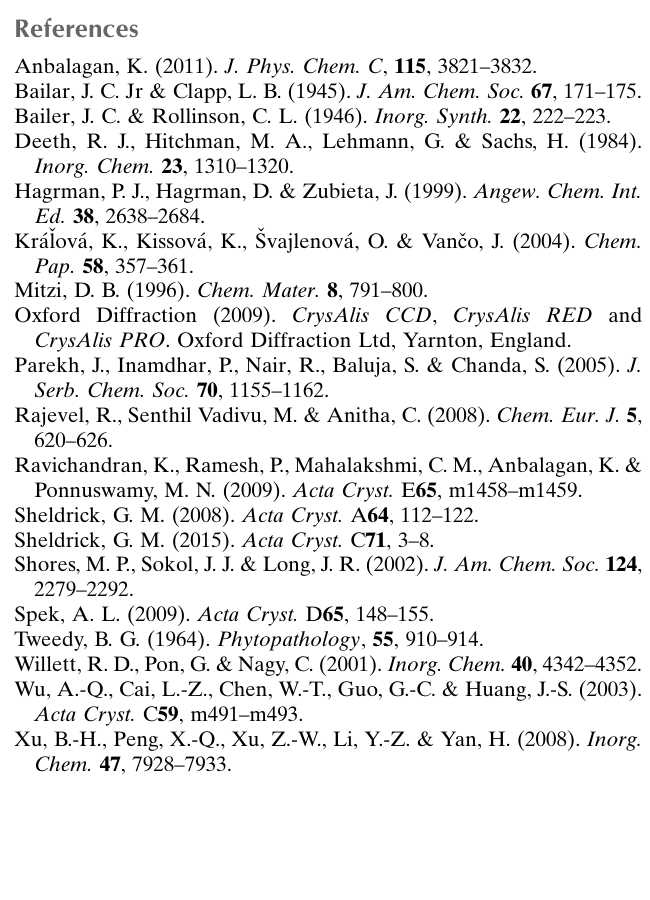
Table 2 Experimental details. Crystal data Chemical formula Crystal system, space